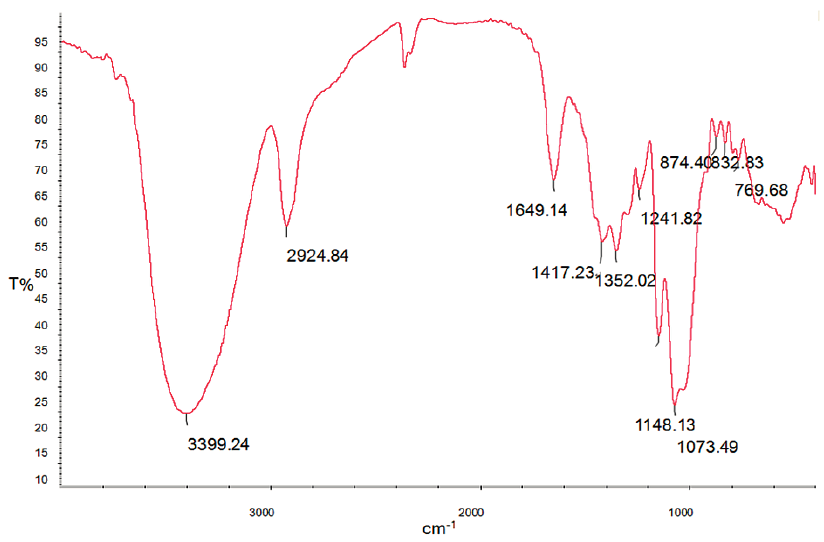
Figure 3. Fourier Transform Infrared (FT-IR) spectroscopy of